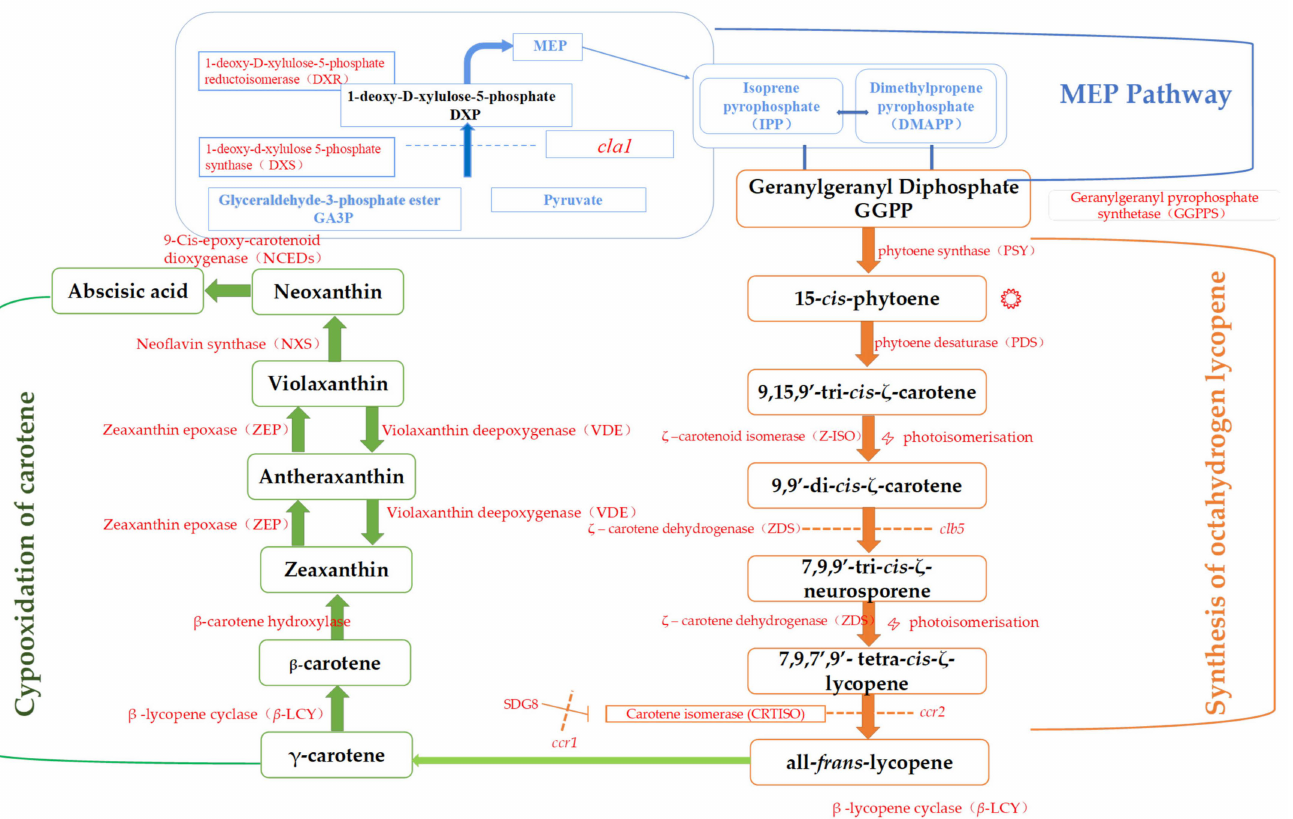
Figure 3. Carotenoid synthesis pathway in mango with red and orange